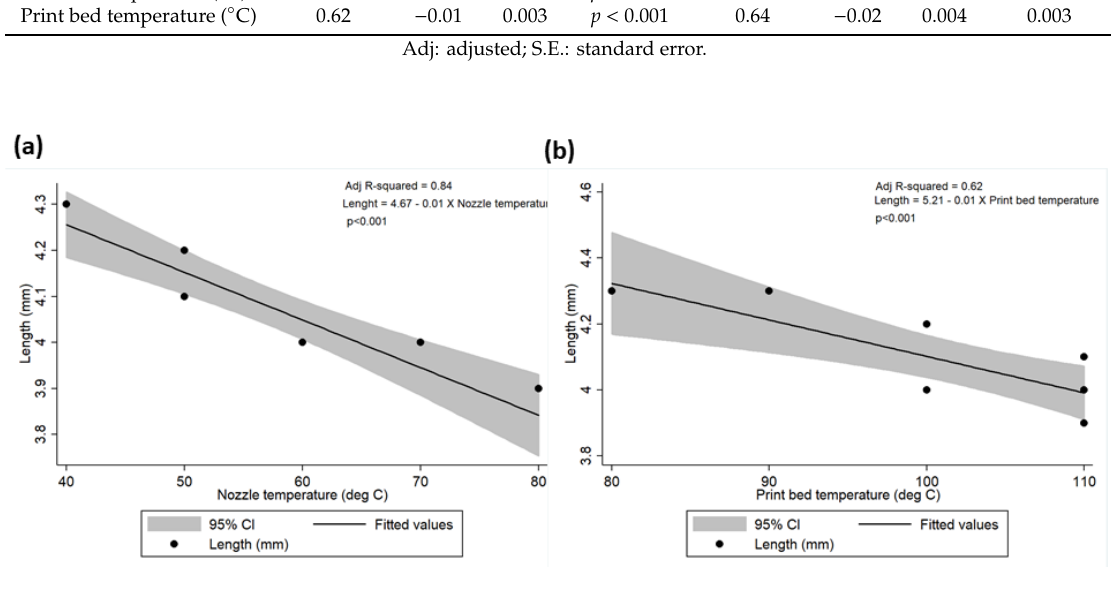
Figure 10. Correlation between meniscus length and ( a ) nozzle temperature and ( b ) print bed temperature.